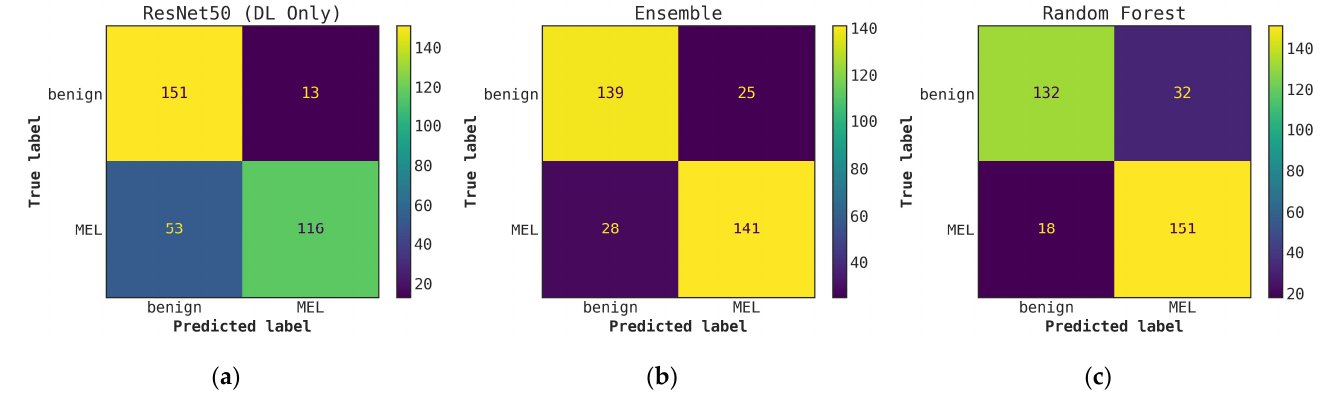
Figure A8. Illustrates a comparison of confusion matrices obtained through cascade generalization, utilizing the probability outputs of the ResNet50 model. ( a ) Confusion matrix for classification using only the ResNet50 model (DL-only, level-0); ( b ) Confusion matrix for classification utilizing the Res- Net50 probability outputs and hand-crafted features, obtained through an ensemble of conventional classifiers (averaging); ( c ) Confusion matrix for classification using the ResNet50 (level-0) probabil- ity outputs and hand-crafted features for the best conventional classifier, random forest. All confu- sion matrices are generated after applying a threshold of 0.5 to the model’s probability outputs to obtain the final predictions.